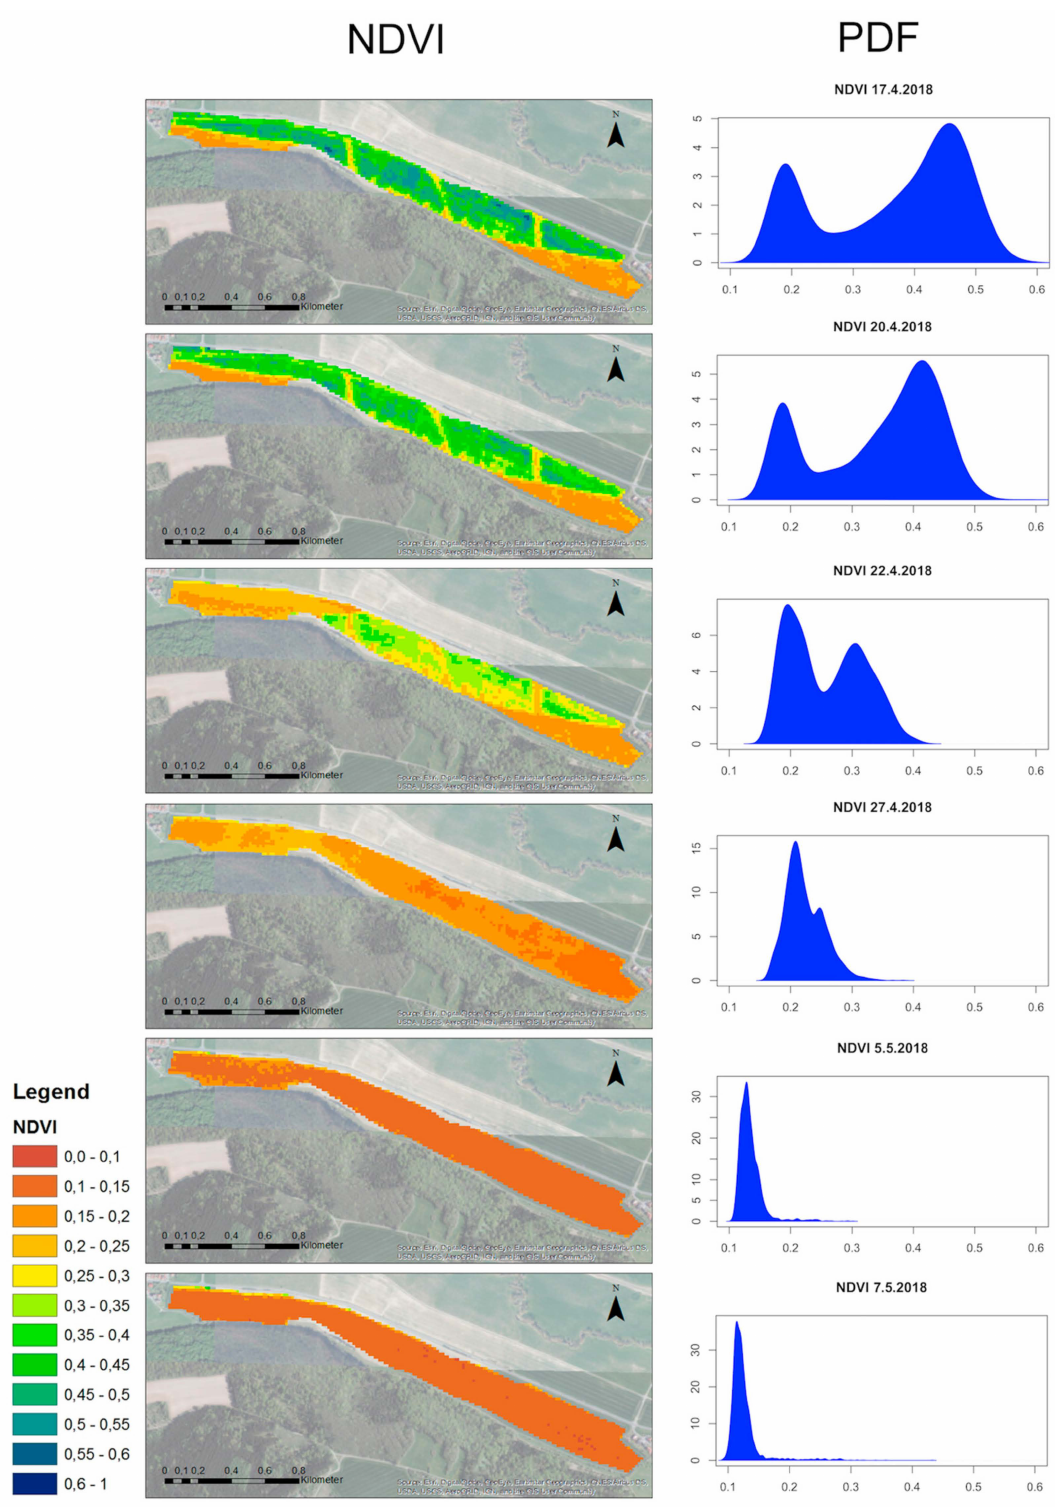
Figure 3. Visualisation of spatio-temporal dynamic of NDVI values for test site Harraser Leite and appropriate probability density